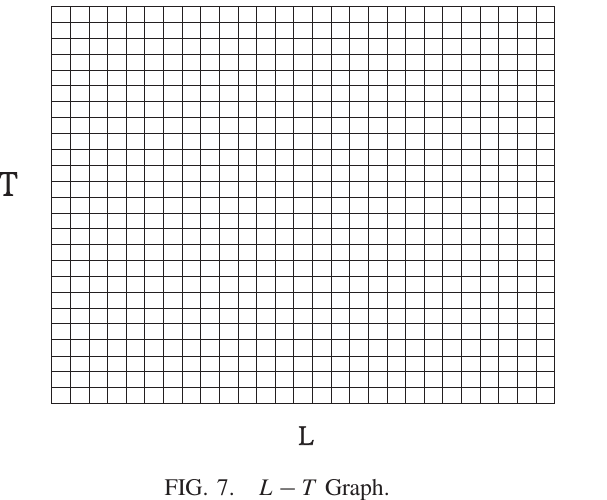
FIG. 7. L − T Graph. FIG. 8. L − T 2